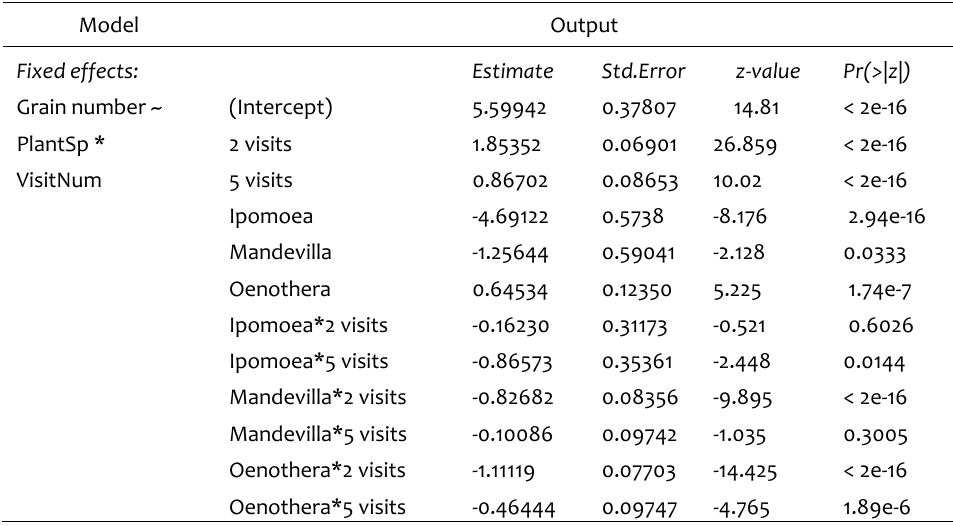
Table 1. Model output for comparisons of number of pollen grains placed on the hawkmoth proboscis across four plant species. Previous visits to experimental flowers and testing date were included as random